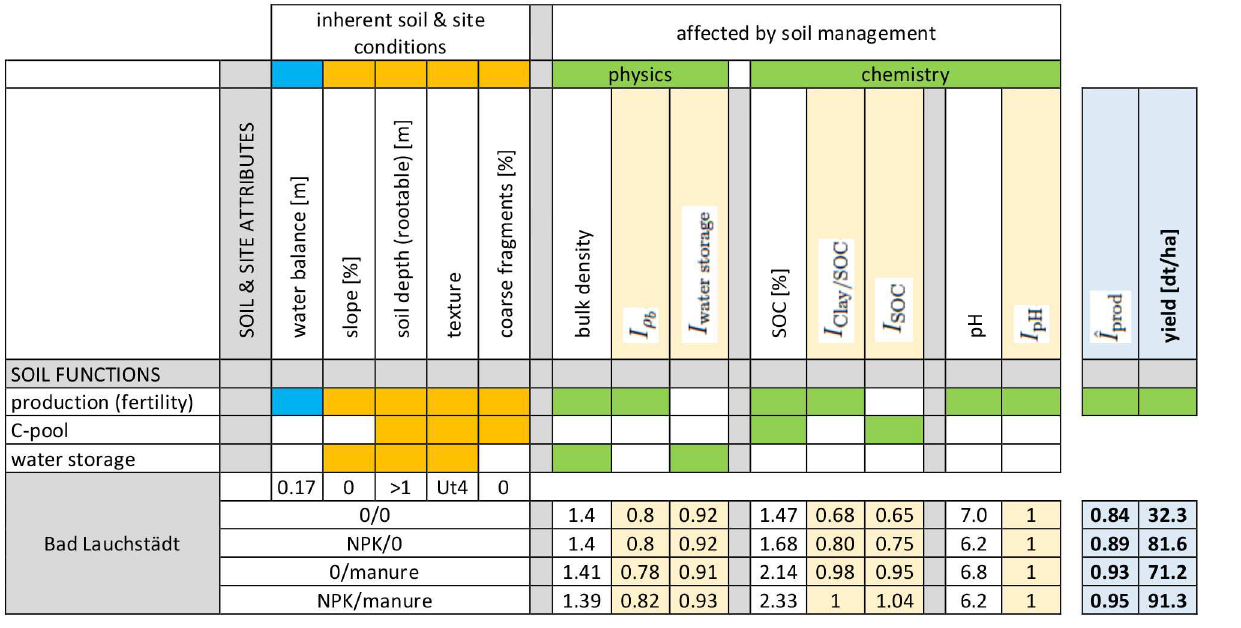
TABLE 2 | Inherent soil and site properties for the Chernozem in Bad Lauchstädt together with manageable soil attributes and related indicator values according to Figure 3 for four experimental plots which received different amounts of fertilizers (NPK/manure) over a period of more than 100